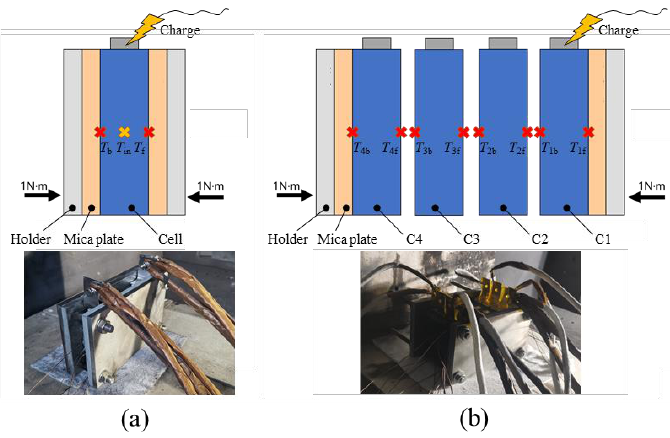
Figure 5. Overcharge abuse test. ( a ) cell test; ( b ) module test.